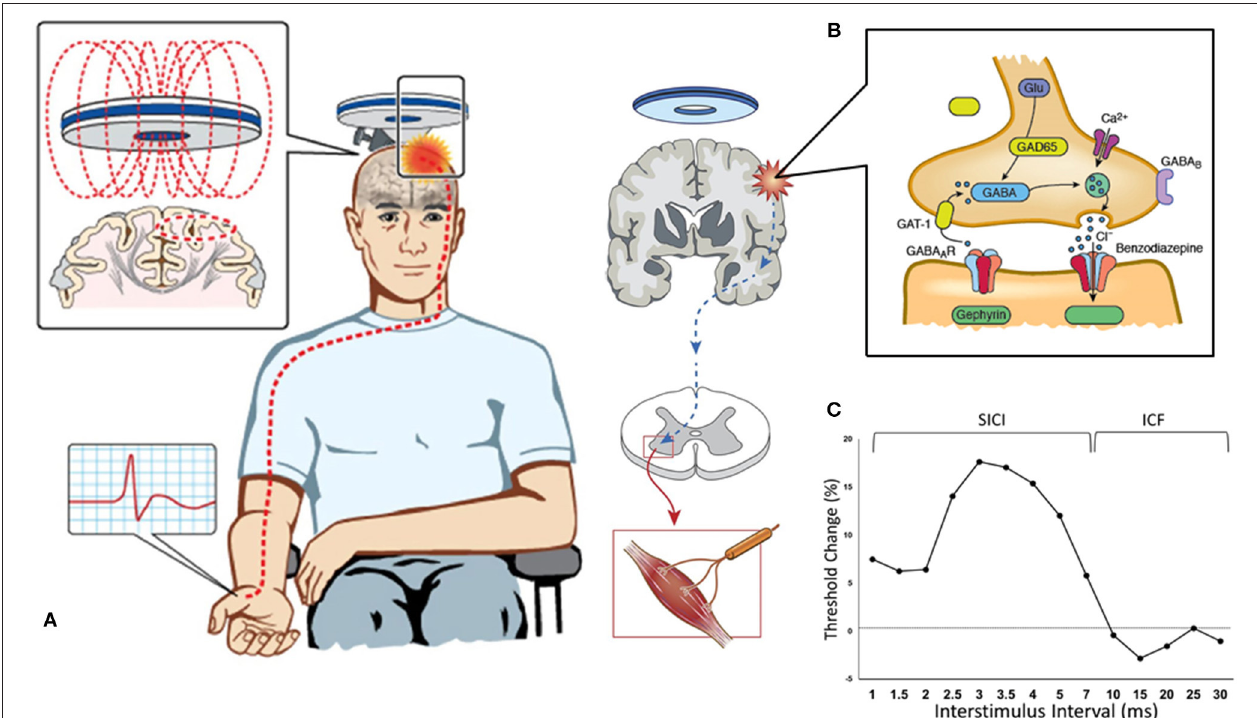
FIGURE 1 | Paired-pulse threshold tracking transcranial magnetic stimulation (TMS). (A) TMS coil placed over the vertex activates the primary motor cortex and the response (motor evoked potential, MEP) is recorded from the contralateral abductor pollicis brevis muscle. (B) TMS parameters are mediated by a complex interplay between intraneural circuits and cortical output cells, with cortical interneurons mediating inhibition by activation of GABAergic synapses leading to influx of chloride anions (Cl − ) and hyperpolarization of post-synaptic neurons. (C) Change in stimulus intensity required to achieve a target MEP of 0.2mV ( ± 20%) is used to quantify SICI (which is recorded with interstimulus intervals between 1–7ms) and ICF (between